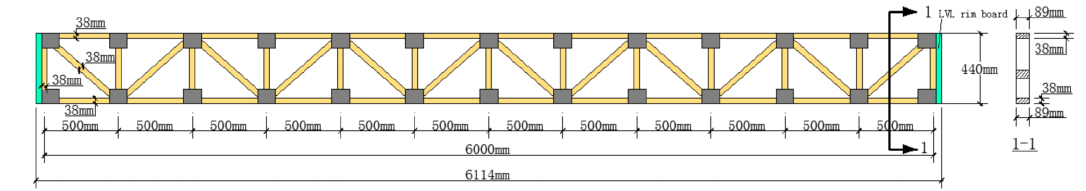
Figure 2. Dimensions of single truss